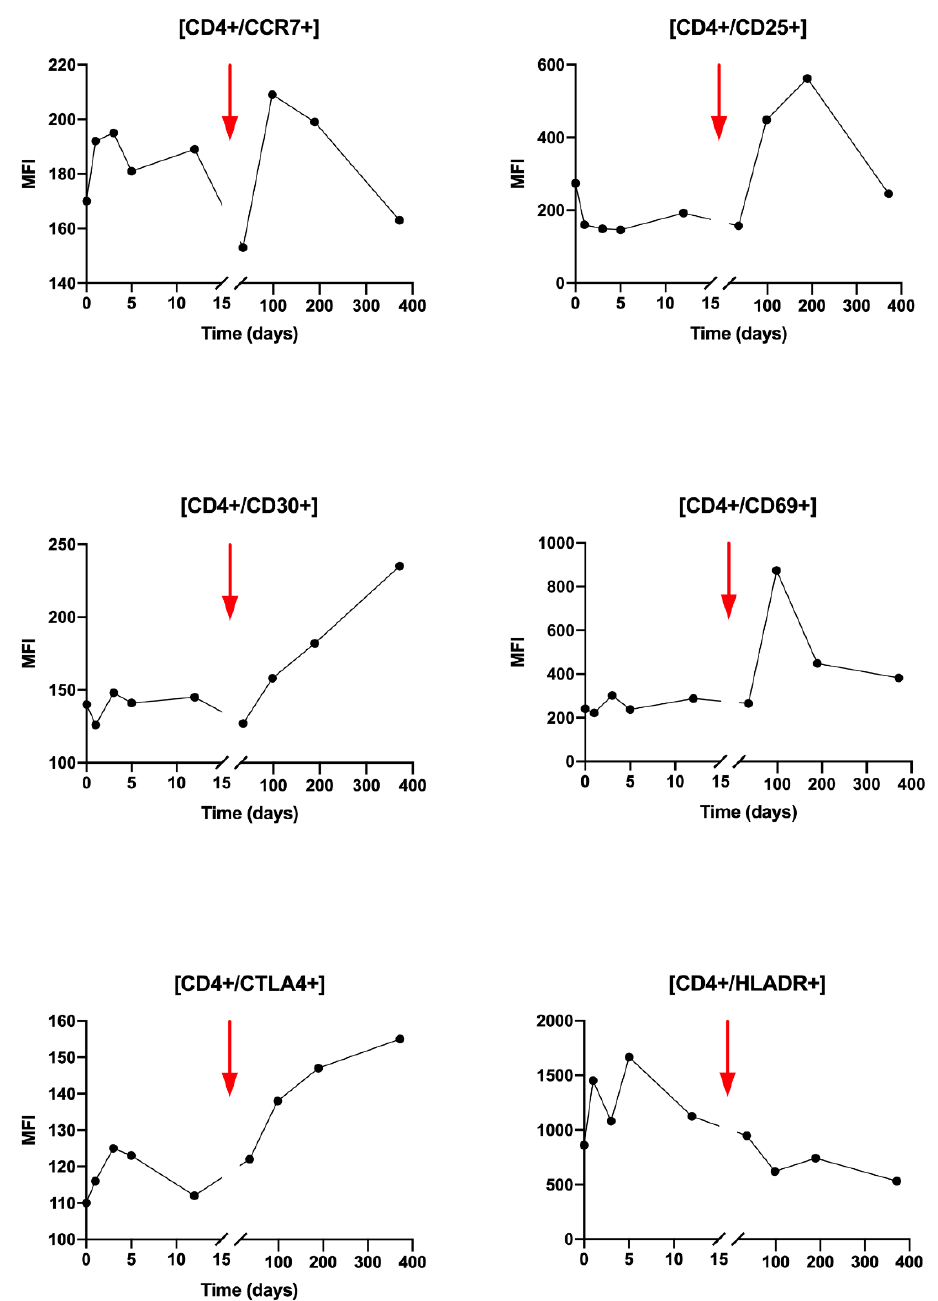
Figure 4. Analysis of CD4 + T lymphocytes activation state by flow cytometry for several activation markers: CCR7, CD25, CD30, CD69, CTLA4, HLADR. Results are presented over time (days) and